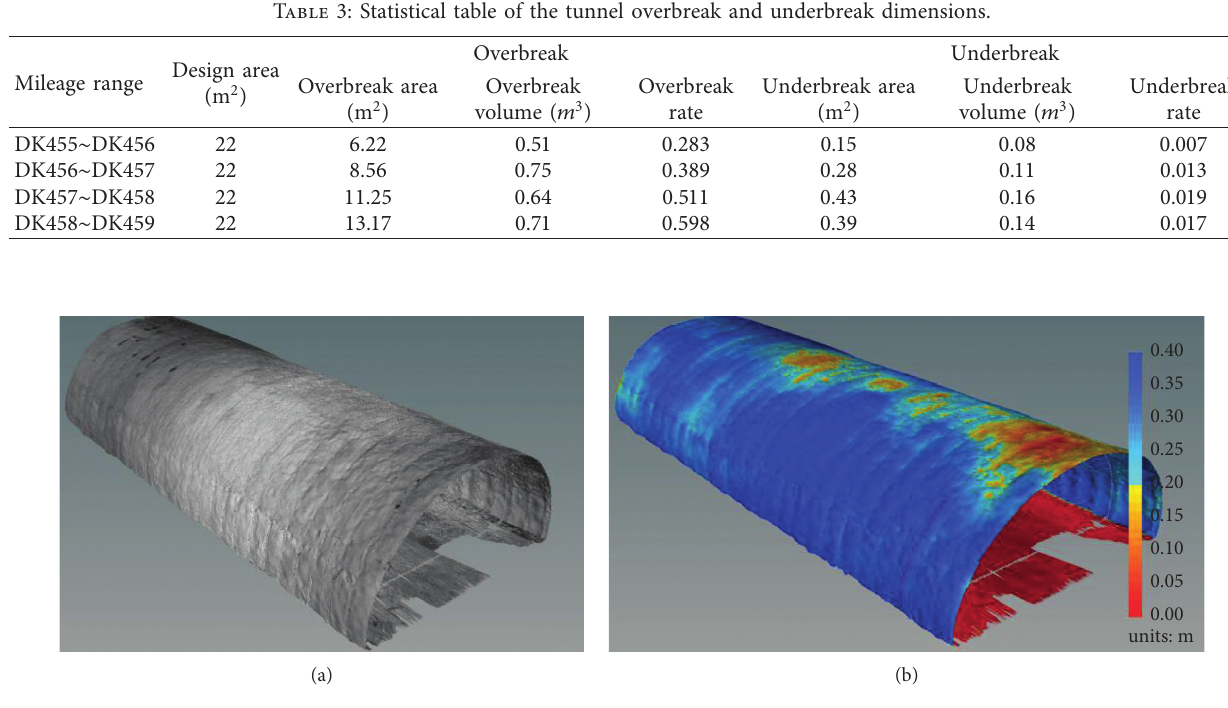
Figure 14: Primary support clearances’ scanning cloud map of the tunnel. (a) 3D laser scanning point cloud. (b) Primary support clearances’ scanning map.